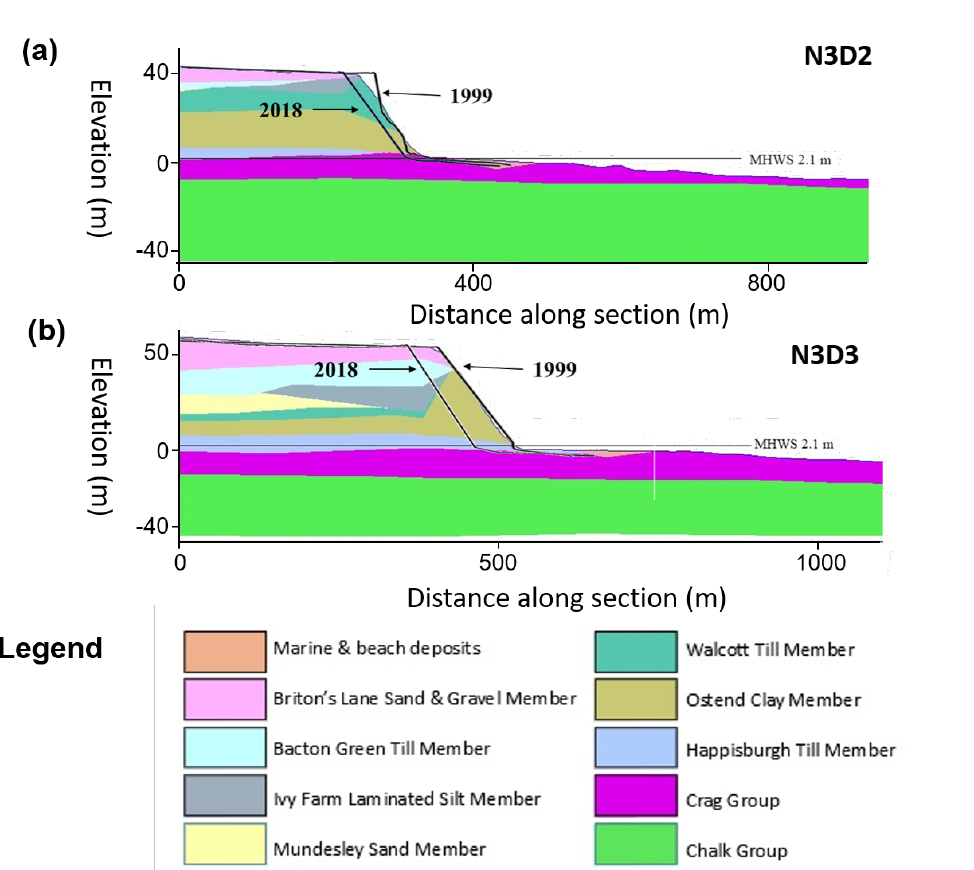
Figure 10. Cross-sections extracted from the 3D lithological model at the same locations as transects N3D2 ( a ) and N3D3 ( b ). Topographic profile elevation for years 1999 (same date of the Digital Terrain Model (DTM) used for the model) and 2018 (last date available)